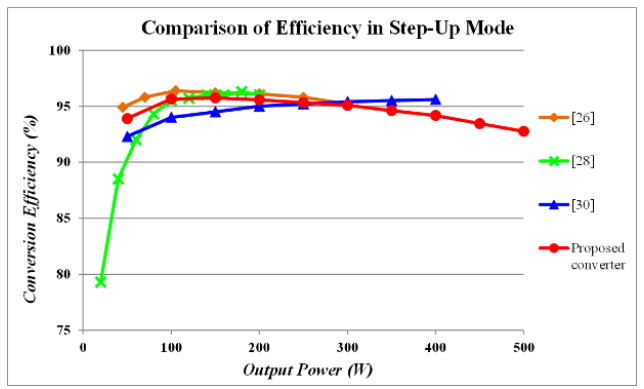
Figure 21. Comparison of the energy conversion efficiency of the proposed converter in the step-up mode with those of the converters in [26,28,30].